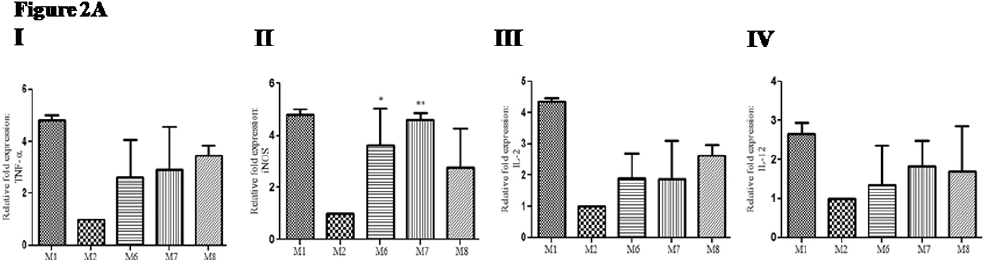
Fig. 2A. Change in pro-inflammatory cytokines gene expression in infected mice upon therapeutic use of recombinant cytokine(s): After sacrifice, splenocytes from mice were immediately stored in RNAlater and after that Trozole was added. mRNA was isolated and cDNA was prepared. RT-PCR based gene expression was estimated using GAPDH housekeeping for normalization of gene expression. Furthermore, mean gene expression of infected group of mice (M2) was used for comparisons (fold change in gene expression) in recombinant cytokines treated groups (M6, M7 and M8) of mice and uninfected group (M1) (I) Gene expression of TNF- a (II) Gene expression of iNOS(III) Gene expression of IL-2 (IV) Gene expression of